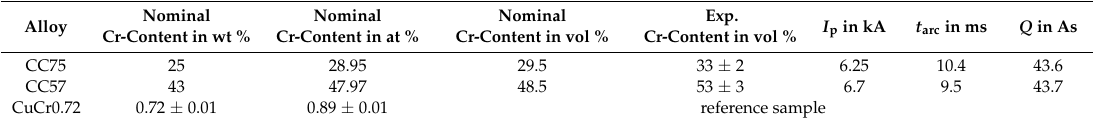
Table 1. Characteristics of and switching parameters for the investigated contact material.